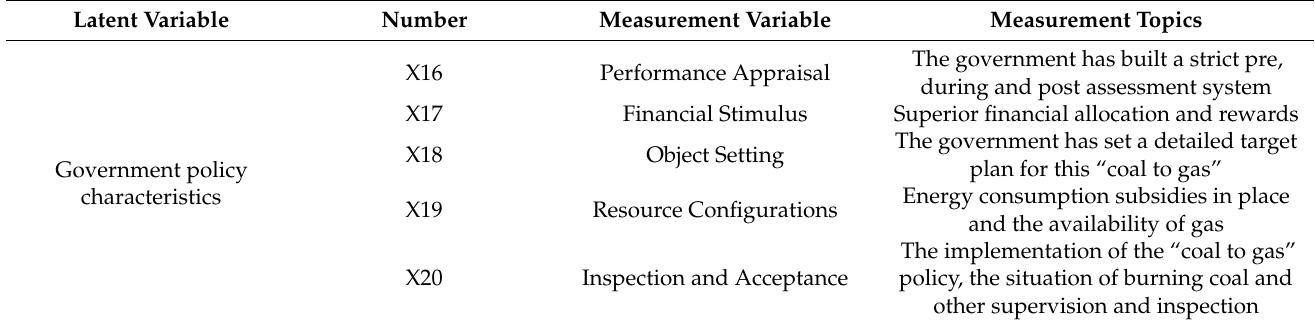
Table 2. Design of government policy characteristics.